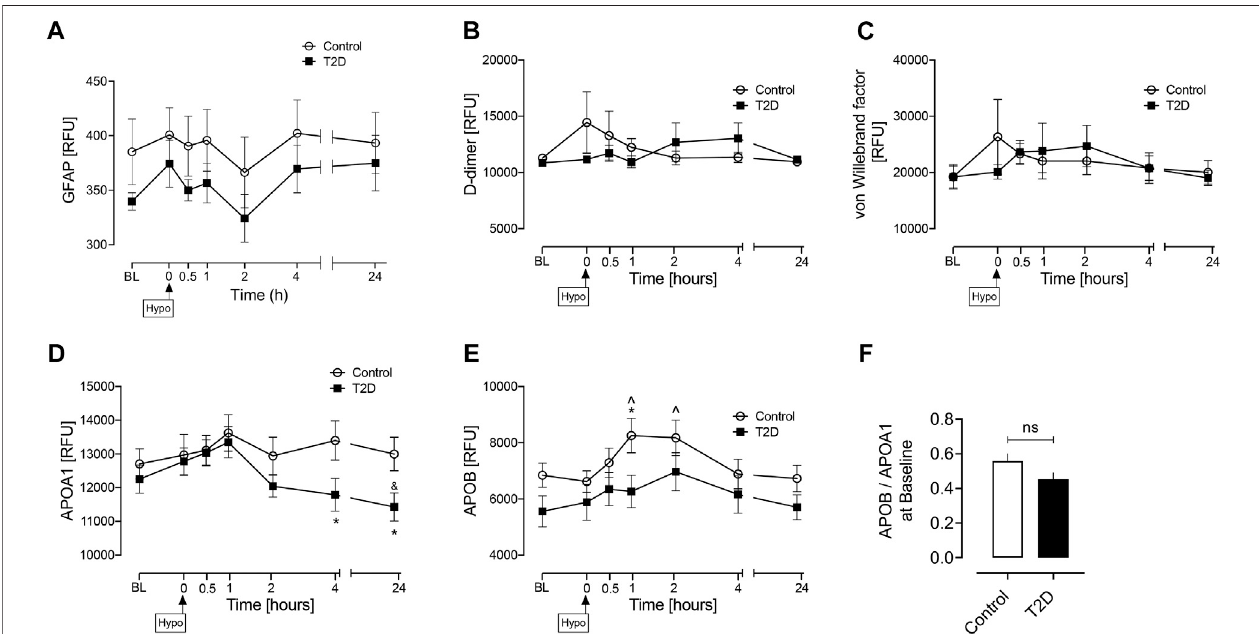
FIGURE3| CirculatorylevelsofpreviouslyreportedAISduetoLVObiomarkersatbaseline,athypoglycemia,andpost-hypoglycemiatimepointsinT2Dandcontrol subjects. Blood sampling was performed at baseline (BL), at hypoglycemia (0 min) and post-hypoglycemia (30 min, 1-h, 2-h, 4-h, and 24-h) for controls (white circles) andforT2D(blacksquares).Proteomic(Somalogic)analysisofproteinswasundertakenforGlial fi brillaryacidicprotein,GFAP (A) D-dimer (B) vonWillebrandfactor,vWF (C) Apolipoprotein A1, APOA1 (D) Apolipoprotein B, APOB, (E) the ratio of basal levels of apolipoprotein B and apolipoprotein A1 (APOB/APOA1), (F) . Statistics: (A – E) T2Dvscontrol:* p < 0.05,** p < 0.01;T2DBL vs. subsequenttimepoints:$ p < 0.05,$$ p < 0.01;T2Dhypoglycemia vs. subsequenttimepoints:& p < 0.05,&& p < 0.01; Control BL vs. subsequent timepoints: @ p < 0.05; Control hypoglycemia vs. subsequent timepoints: ^ p < 0.05. ^^ p < 0.01; (F) Data presented in the bar graph as mean ± SEM; ns, not signi fi